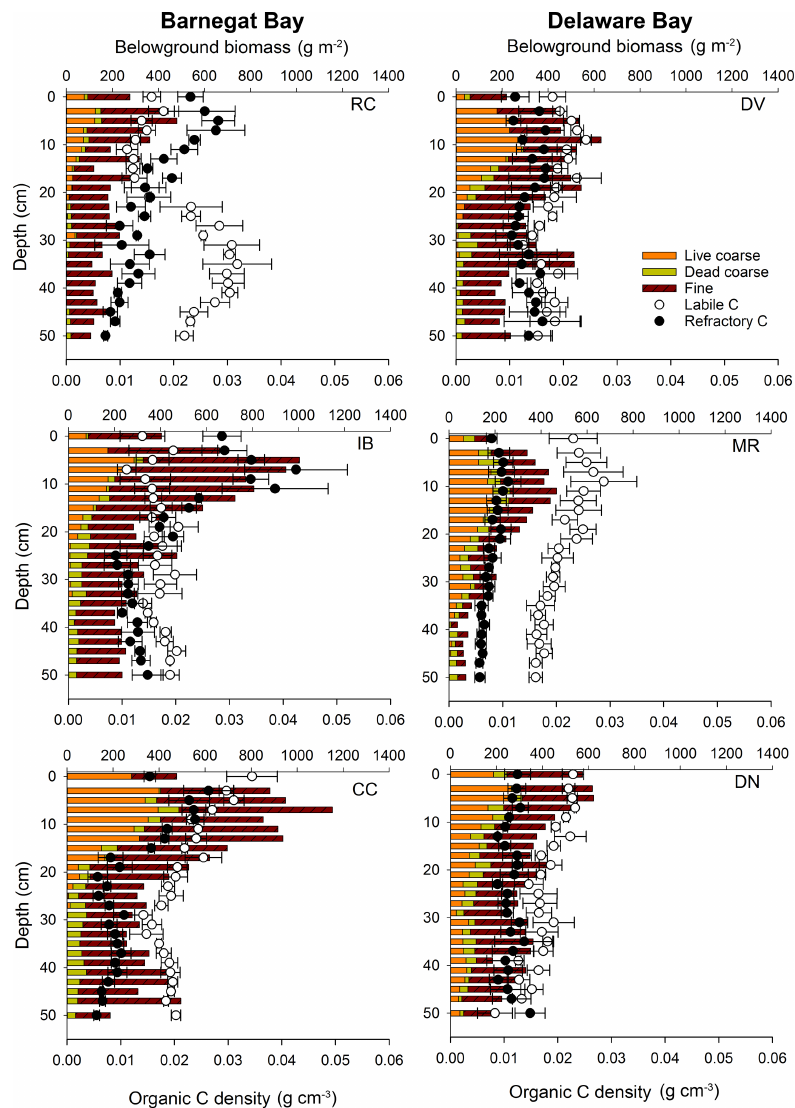
Figure 5. Belowground biomass and labile and refractory organic C density profiles in marshes of two mid-Atlantic estuaries. Biomass data are means (standard errors not shown). C density data previously reported in Unger et al.